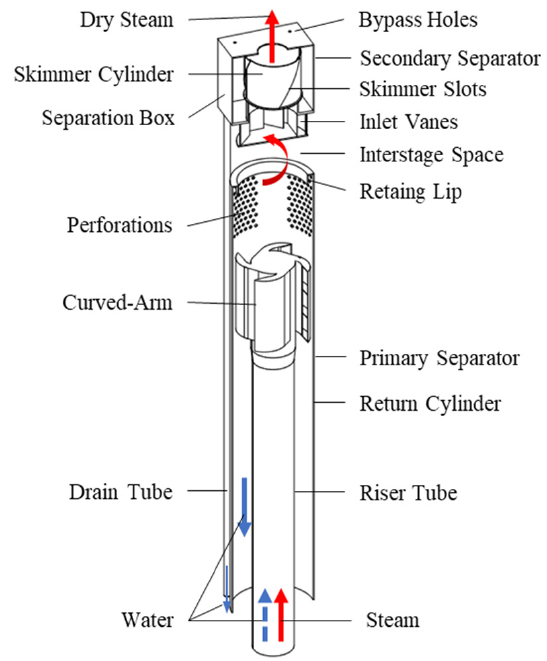
Figure 1. Structure of separation